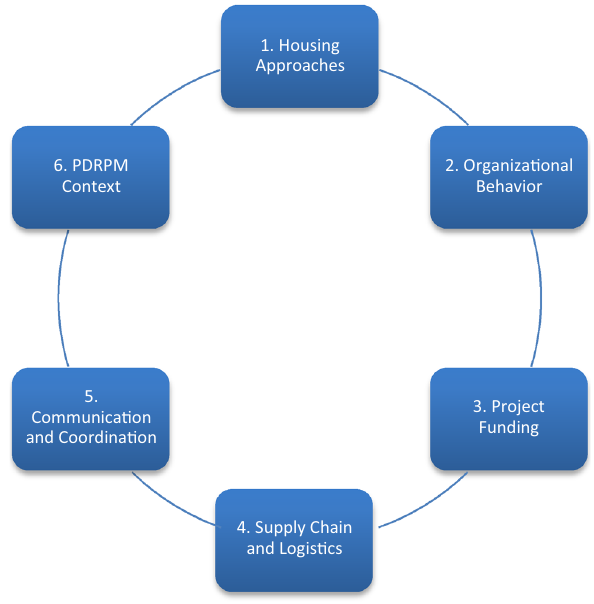
Fig. 2 Principal groups of factors that influence post-disaster recon- struction project management